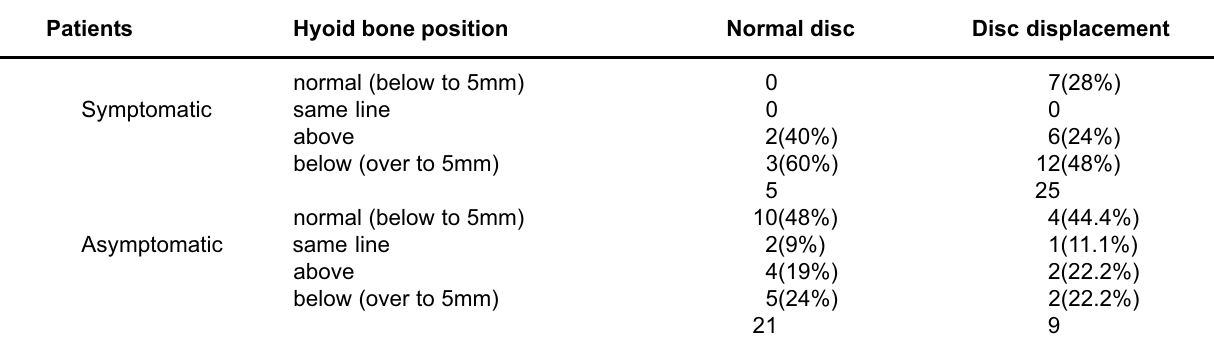
TABLE 4- Distribution and classification of the TMJs of symptomatic and asymptomatic individuals, with and without articular disc displacement, in relation to the values referring to the hyoid bone